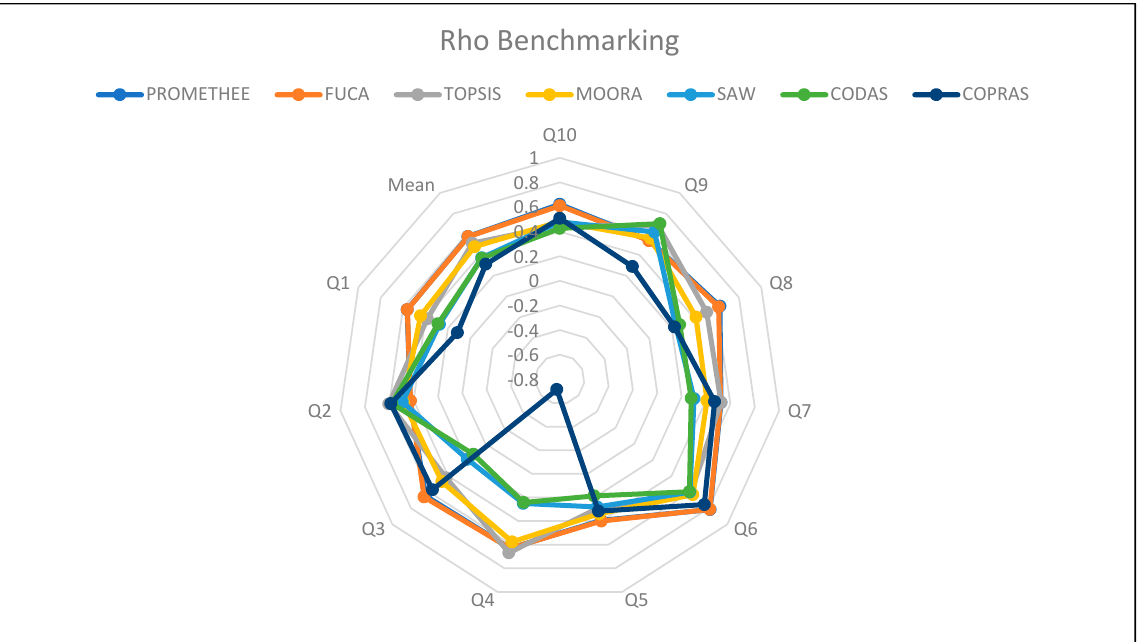
Figure 3. Radar Graph of Performance of MCDMs Based on Rho benchmark. It can be seen from the scatter plot (Figure 4) below that the PROMETHEE&FUCA pair usually produces higher Rho and SD.